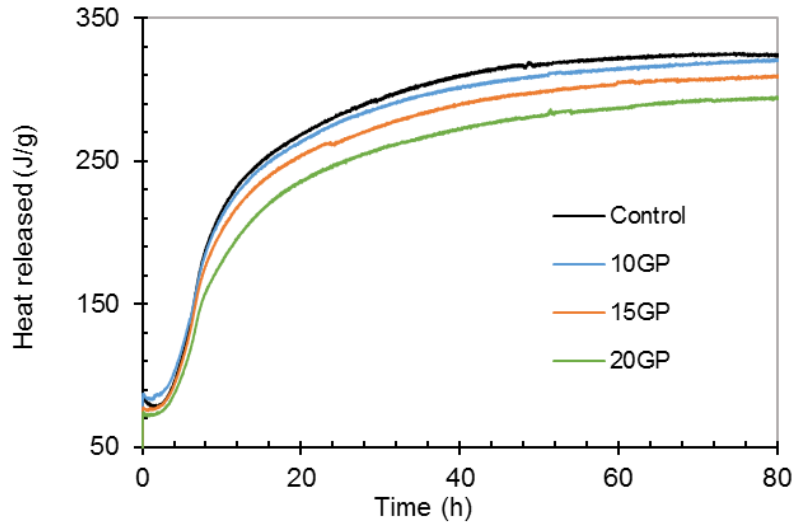
Figure 8. Heat of hydration of CEM I and GP mixes.